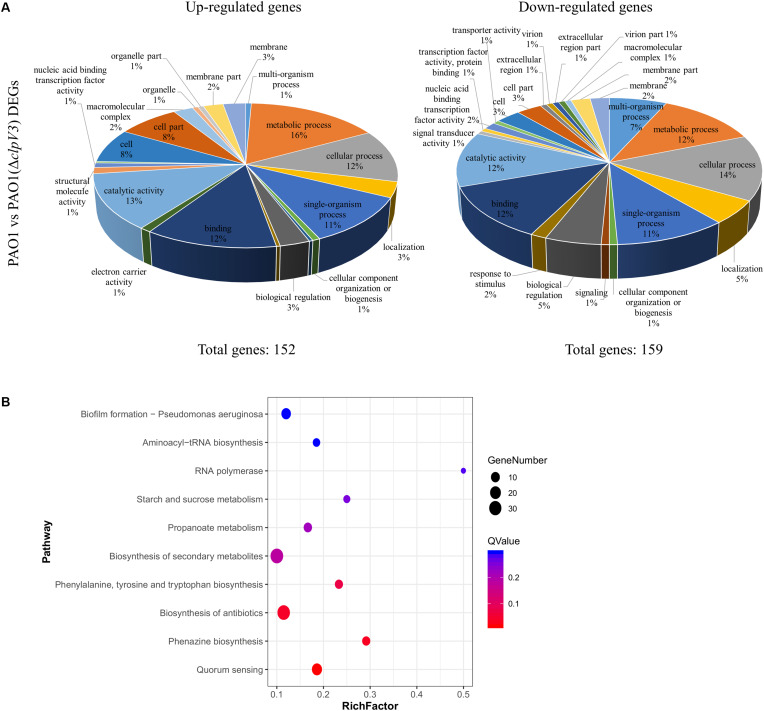
Comparison of the global transcriptomes of PAO1 and PAO1(Δclpv3) by RNA-Seq. (A) Totally 311 genes were significantly differentially expressed in PAO1(ΔclpV3) compared to wild-type PAO1 with absolute fold change >2 and FDR <0.05. Pie charts showing Gene Ontology analysis of the differentially expressed genes outlined in the PAO1 vs PAO1(ΔclpV3), subdivided into up-regulated (left) and down-regulated (right) groups. (B) The top 10 of significant KEGG enrichments between PAO1 and PAO1(ΔclpV3).